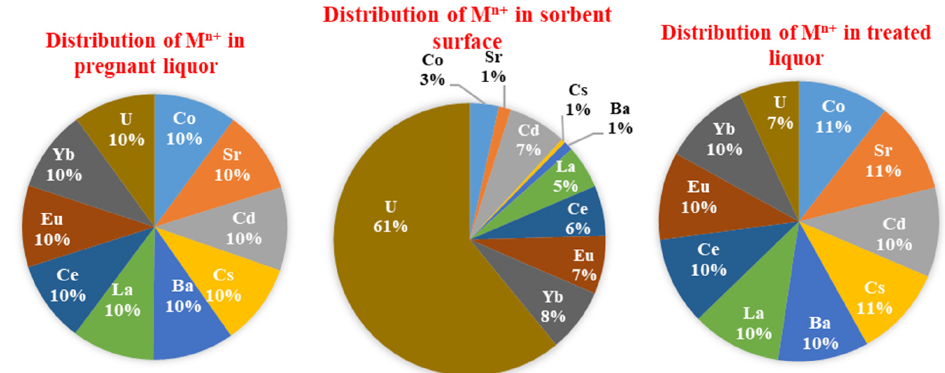
Figure 7. The distribution of the selected metal ions in pregnant liquor, treated liquor, and the Cys- sorbent (molar percentages).